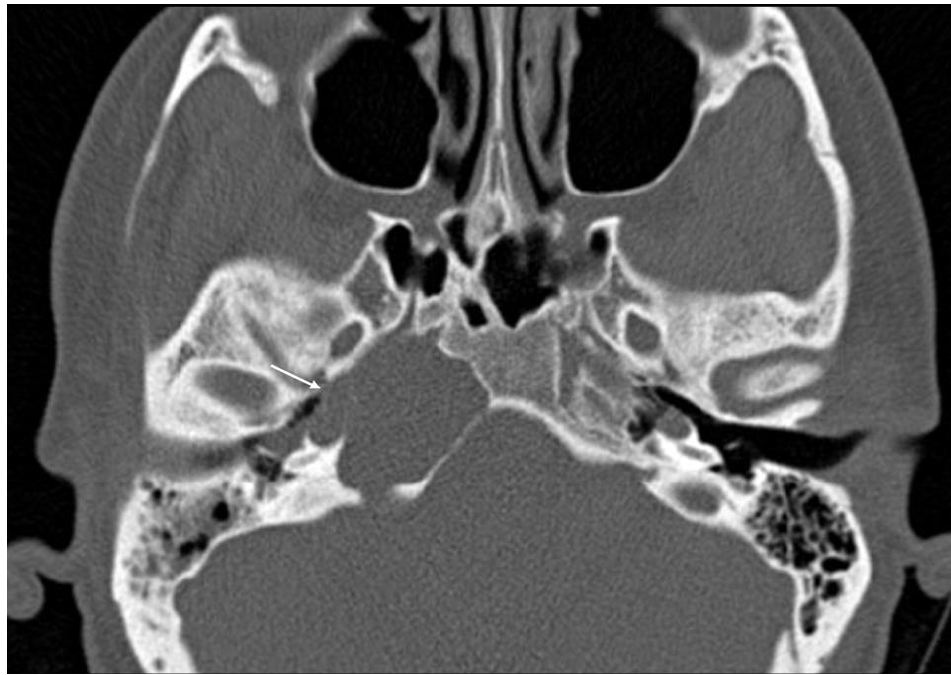
Figure 2. Axial CT scan showing compression of the Eustachian tube by a cholesterol granuloma (white arrow).